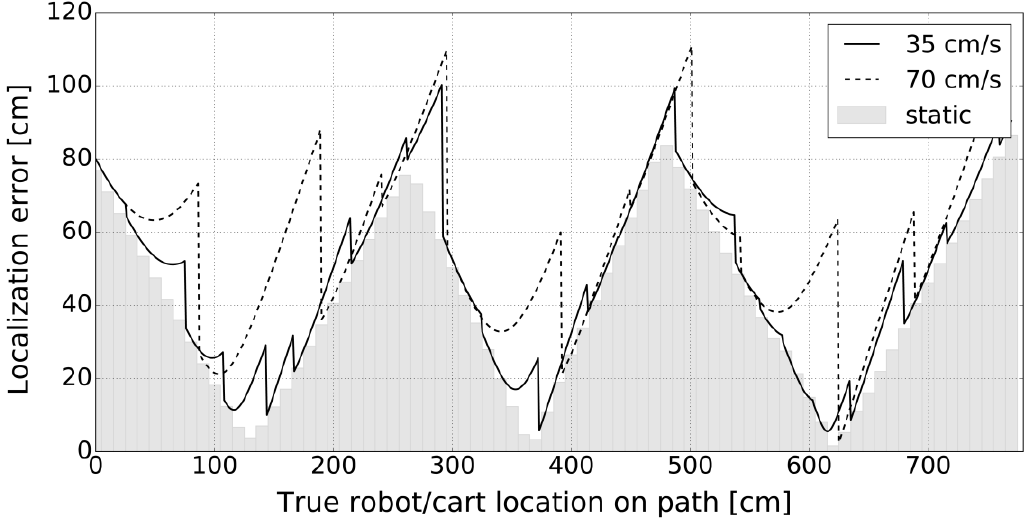
Figure 19. Localization error obtained in E3. Considering the low Static-1D error from the E1 experiment, we can conclude that the Static-2D localization error mainly originates from the distance between the cart true location and the aisles graph and, to a lesser extent, from the AoA measurement error. The Mobile-2D localization error additionally includes a component related to the movement speed and the IR transmit time delays as examined in the experiment E2.